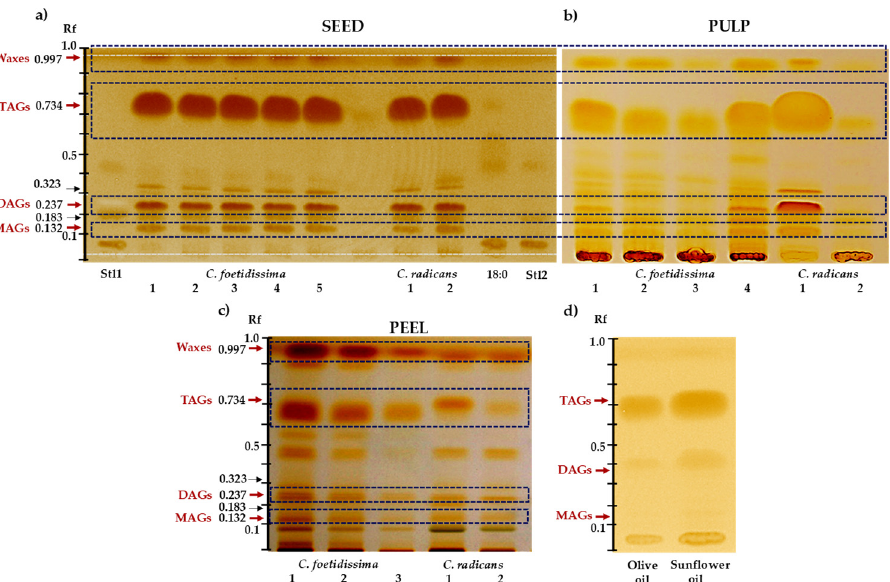
Figure 1. Neutral lipids profiles in fruits of wild Cucurbita species. Neutral lipid profiles of ( a ) seeds, ( b ) pulp and ( c ) peel of C. foetidissima and C. radicans fruits were obtained by HPTLC analysis. They were compared to ( d ) olive oil and sunflower seed oil, respectively and to steric acid (18:0) and two plant sterol standards (Stl1 and Stl2). The fruits were sampled in 2018 from plants growing in the wild in two different locations in the state of Jalisco, M é xico: Vaquer í as, municipality of Ojuelos ( C. foetidissima ) and San Jos é de Gracia, municipality of Tepatitl á n ( C. radicans ). The red and black arrows indicate the strongest signals obtained, corresponding to triacylglycerols (TAGs), diacylglycerols (DAGs), monoacylglycerols (MAGs), waxes and other unidentified compounds. Table 3. Fatty acid composition of Cucurbita seed oils. The composition of the oils extracted from seeds of C. radicans and C. foetidissima was determined by MALDI-TOF. The identity of the most relevant m/z ions was determined on the basis of the standards shown and on published data.